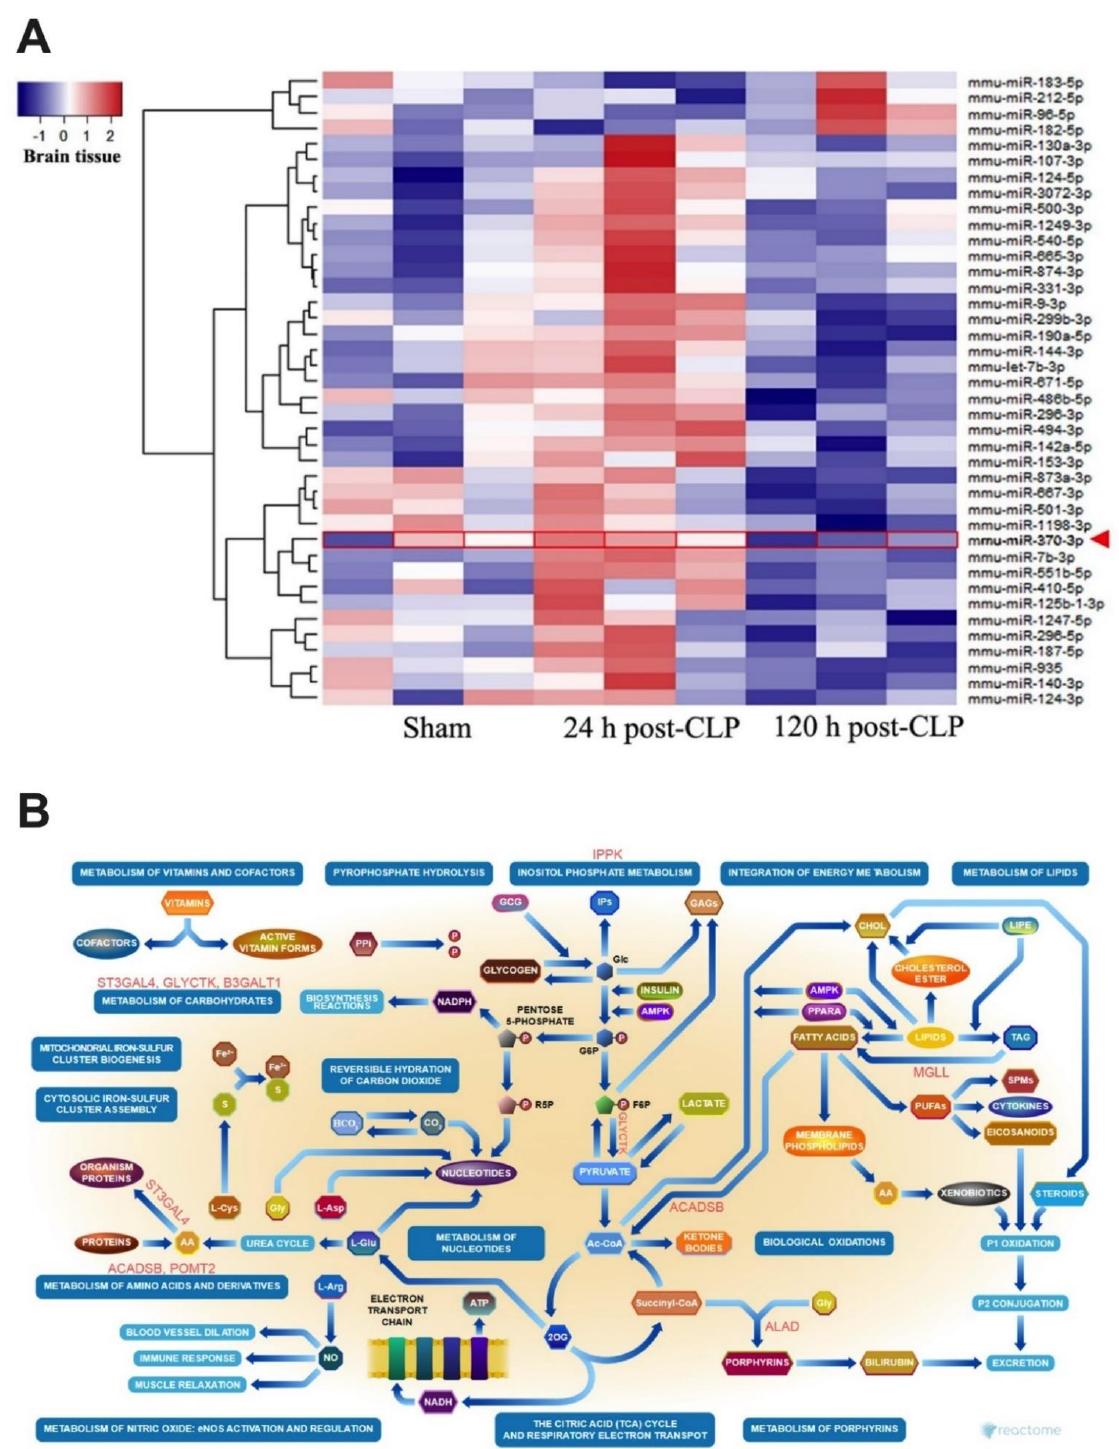
Figure 5. Heatmap illustration of microRNA arrays from the brains of mice with 24 h post-sham (sham), 24 h post-cecal ligation and puncture (CLP), and 120 h post-CLP (120 h post-sham group is not performed due to the similarity to 24 h post-sham) ( A ) ( n = 3/group) and the predicted pathways that are associated with miR370-3p from the Reactome database are demonstrated ( B ). The arrowhead indicates miR370-3p on the analysis. The letters in red color are the predicted genes that are associated with miR370-3p from the Reactome analysis (more details on Figure 6) (This picture was provided by Biorender.com (accessed on 5 January